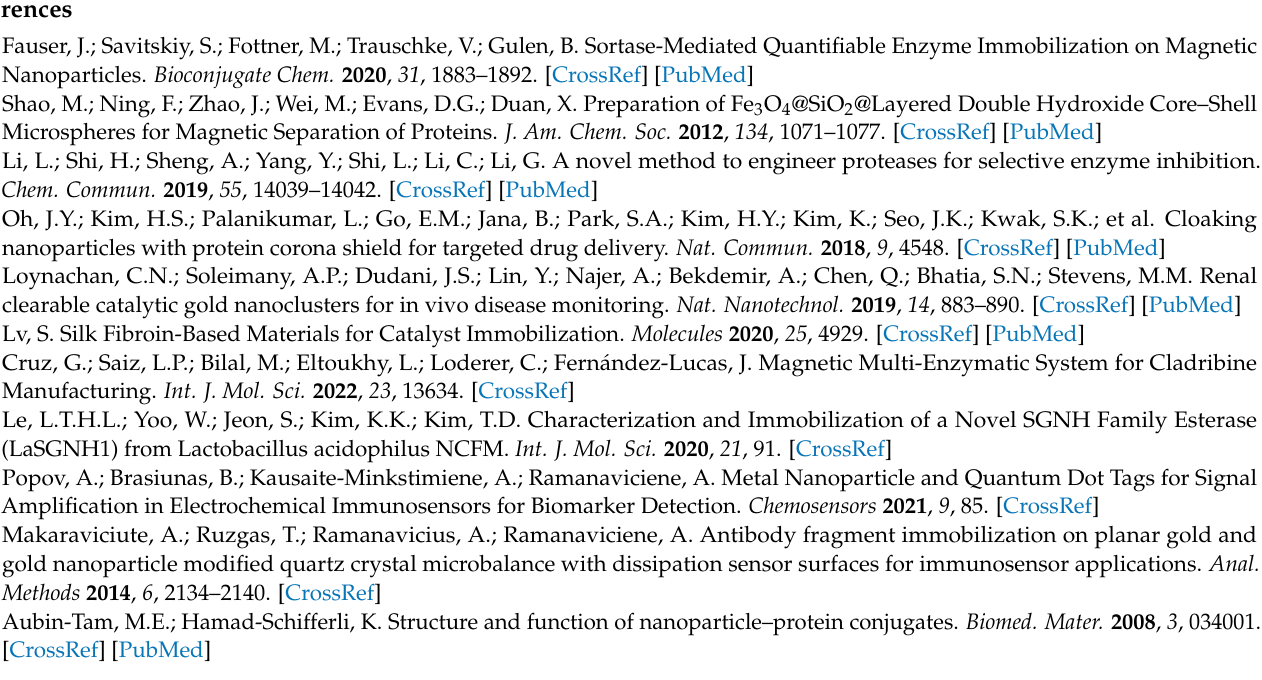
Figure S7: The fluorescence emission spectrum of target protein eGFP-ELP 8 -NGL excited at 488 nm, which is same as free